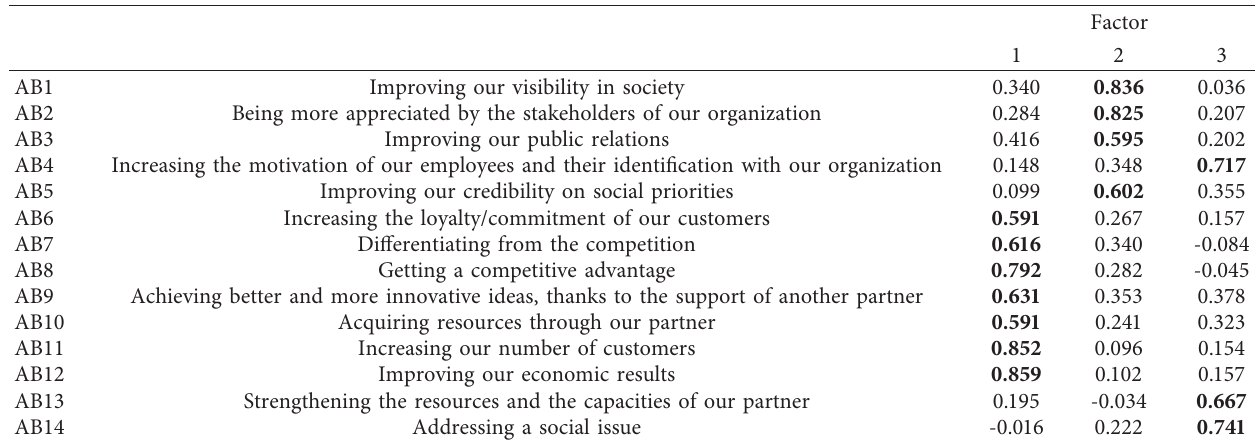
Table 4: Factor analysis